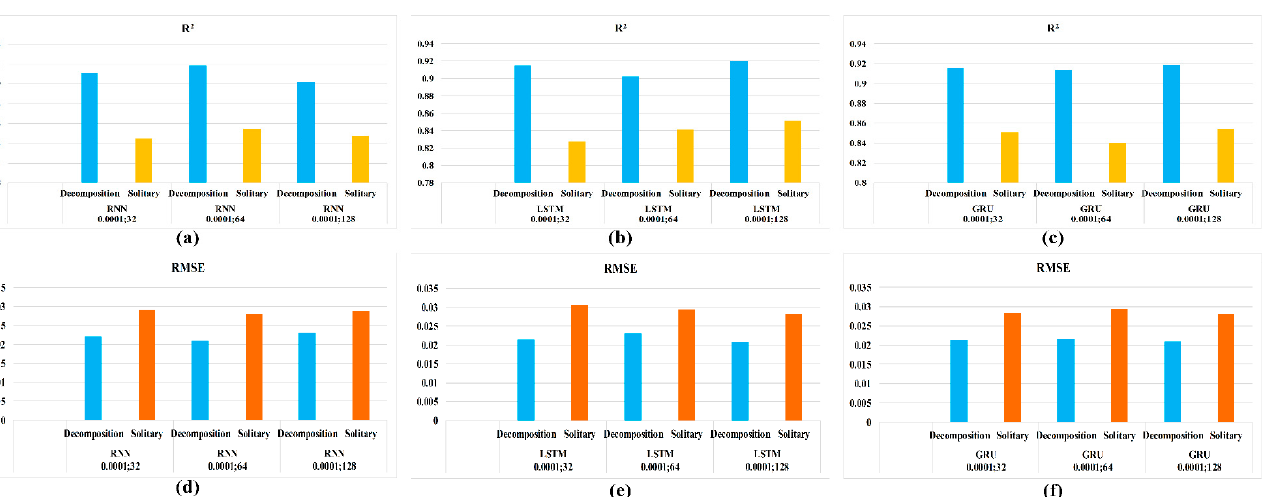
12 of 16 Figure 9. RMSE loss of the three models. The performance results of the combined decomposition and deep learning models are shown in Figure 10. The coefficients of determination, as shown in Figure 10a–c, represent the accuracy of the predicted values of the models compared to the true values, and should be as high as possible. A model with a learning rate of 0.0001 was used as a representative model to analyze the effect of different batch sizes on the model at the same learning rate. For the RNN models, the trend of the coefficient of determination changes consistently with the increase in batch size, with the decomposition method, and with the